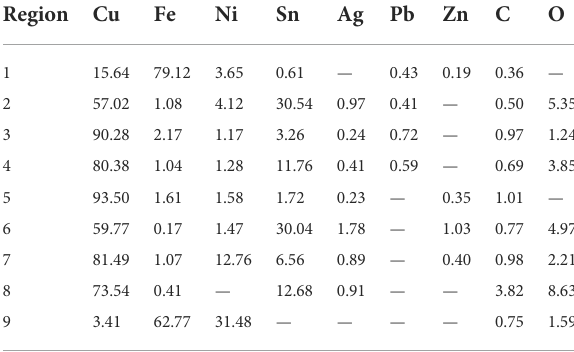
TABLE 2 Analysis results of energy spectrum components at each point (wt%). Region